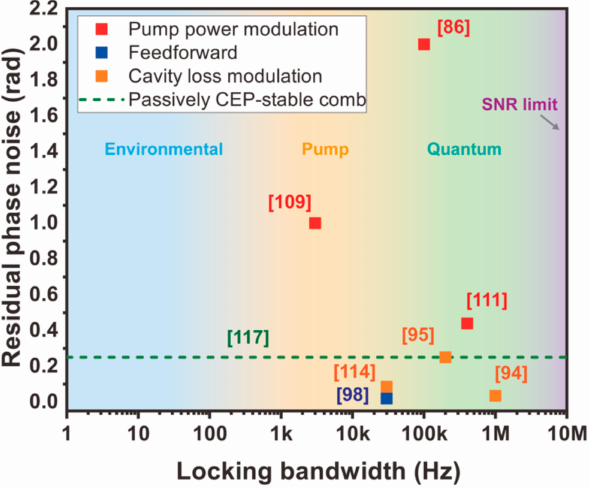
Figure 6. Representative performance of carrier-envelope phase noise reduction methods presenting as locking bandwidth vs. residual phase noise. The different color-shaded regions indicate noise of free-running comb originating from environmental noise, pump noise, quantum noise and SNR